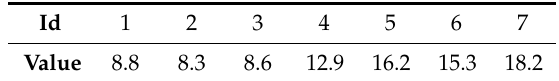
Table 5. The historical data of SOF2.